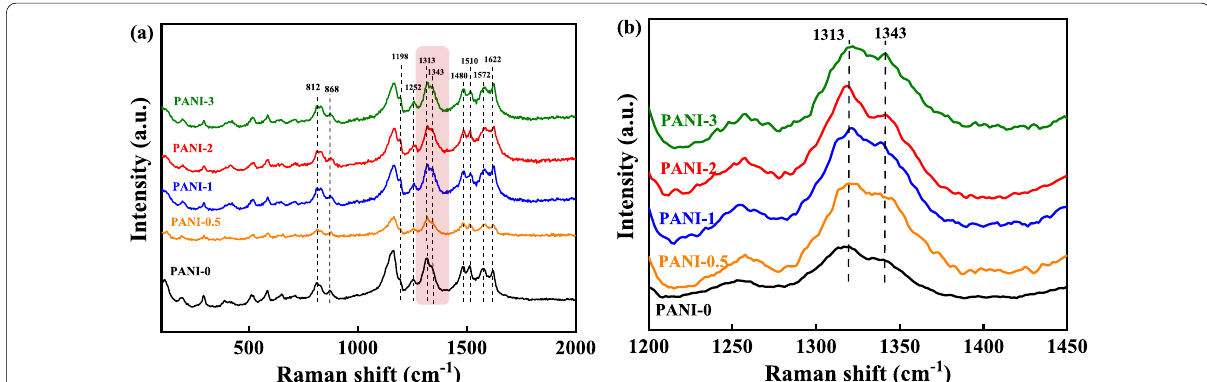
Fig. 2 a Raman spectra of the PANI porous films at different copper concentrations. b Raman spectra of the partial enlargement of the red area of Fig. 1a